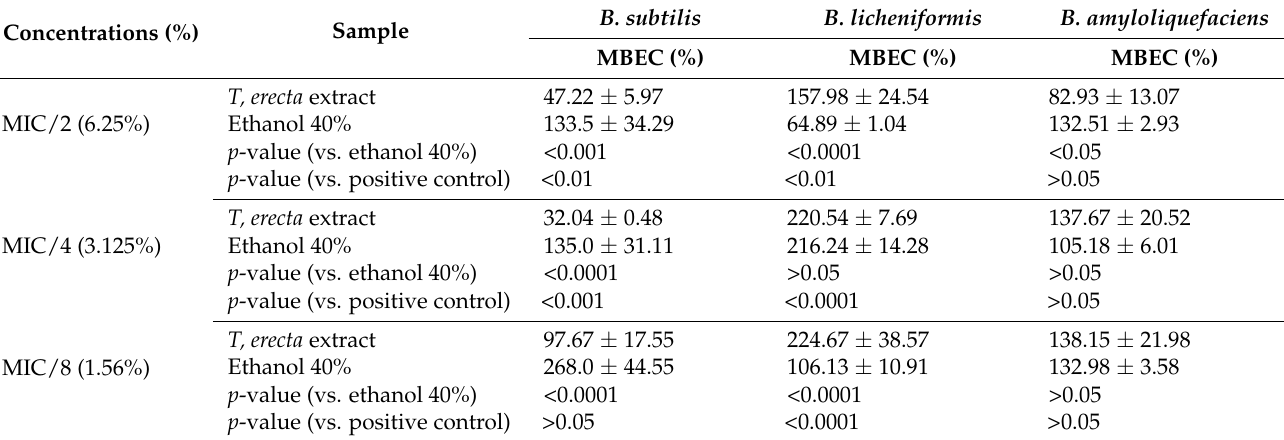
Table 5. Antibiofilm activity of T. erecta extract and the corresponding solvent concentration against Bacillus sp.